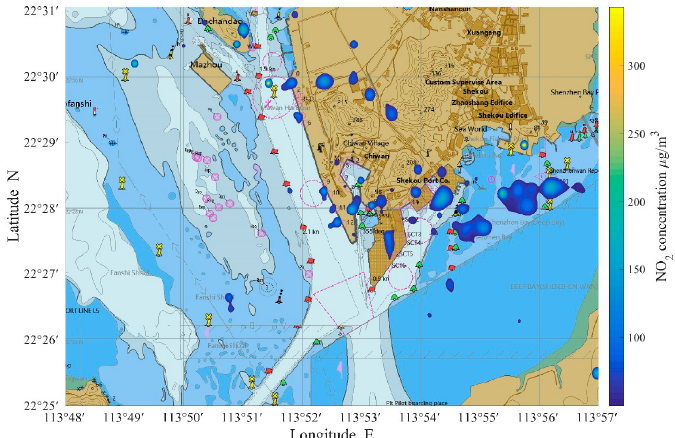
Figure 9. NO 2 concentration distribution at 1:00 (greater than 50 μ g/m 3 ).